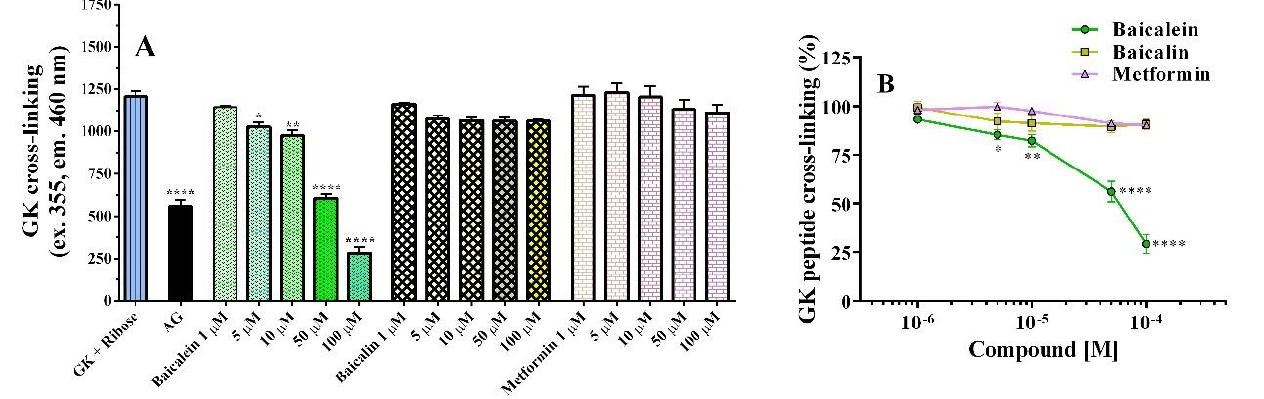
Figure 4. Effects of baicalein (green bars), baicalin (yellow bars), and metformin (pink bars) on GK cross–linking formation after 2 days of incubation of 26.7 mg/mL GK peptide (0.1 M) with 40 mg/mL ribose (0.27 M) reported as fluorescence ( A ) and percentage of control fluorescence ( B ). Aminoguanidine (2.5 mM, AG) was the positive control. Data are the mean ± SEM of 3–6 experiments. * p < 0.05, ** p < 0.01, and **** p < 0.0001 versus GK cross–linking (GK + Ribose).